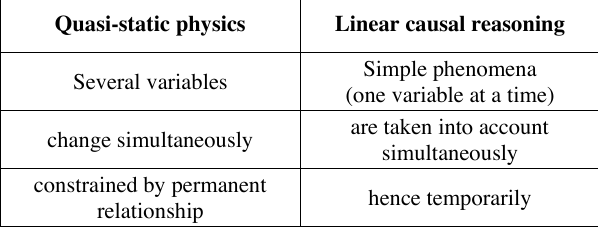
Table 1. A term-to-term contrast between